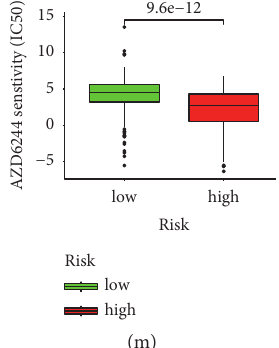
Figure 8: (a–b) The correlation of immunocyte infiltration fraction with risk score. (c–e) PDCD1, LAG3, and CTLA4 expressed levels in high- and low-risk groups. (f–m) The abilities of the risk model to predict drug sensitivity: carboplatin, cisplatin, gefitinib, imatinib, dasatinib, erlotinib, oxaliplatin, and AZD6244. ∗∗∗ represents P < 0 . 001, ∗∗ represents P < 0 . 01, ∗ represents P < 0 . 05, and ns represents not